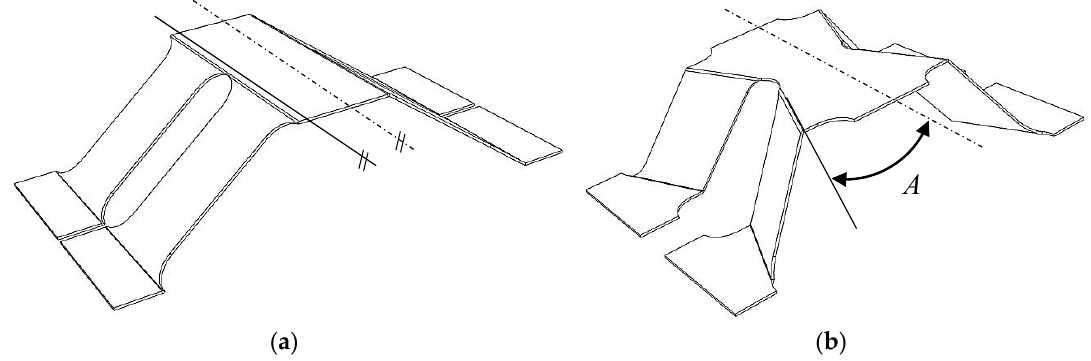
Figure 1. Schematic representation of the cellular structure: ( a ) perforated trapezoidal corrugation; ( b ) mechanically expanded perforated trapezoidal corrugation resulting in a pyramidal structure.